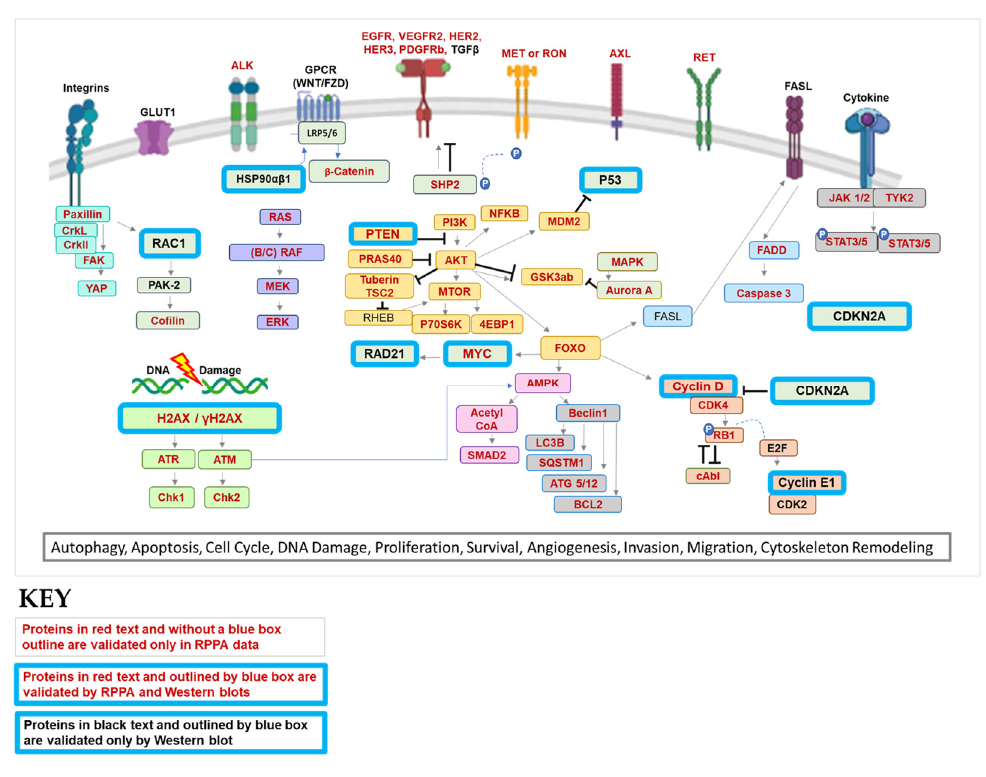
Figure 15. Activated pathways are preserved among P0 and their respective PDX passages. Heatmap of total and phosphoproteins via RPPA. Sarcomas (HT72, HT77, HT87, and HT74) and Wilms tumor (HT98, HT120, and HT139). Each data point represents the average of 3 replicate printed spots. All final data values were normalized to total protein following the subtraction of negative control. Coefficient of variation (CV) among the replicate spots of <10% [23] was used as the cut-off for positive signals. Arrows indicate targets that are downstream in the pathway.